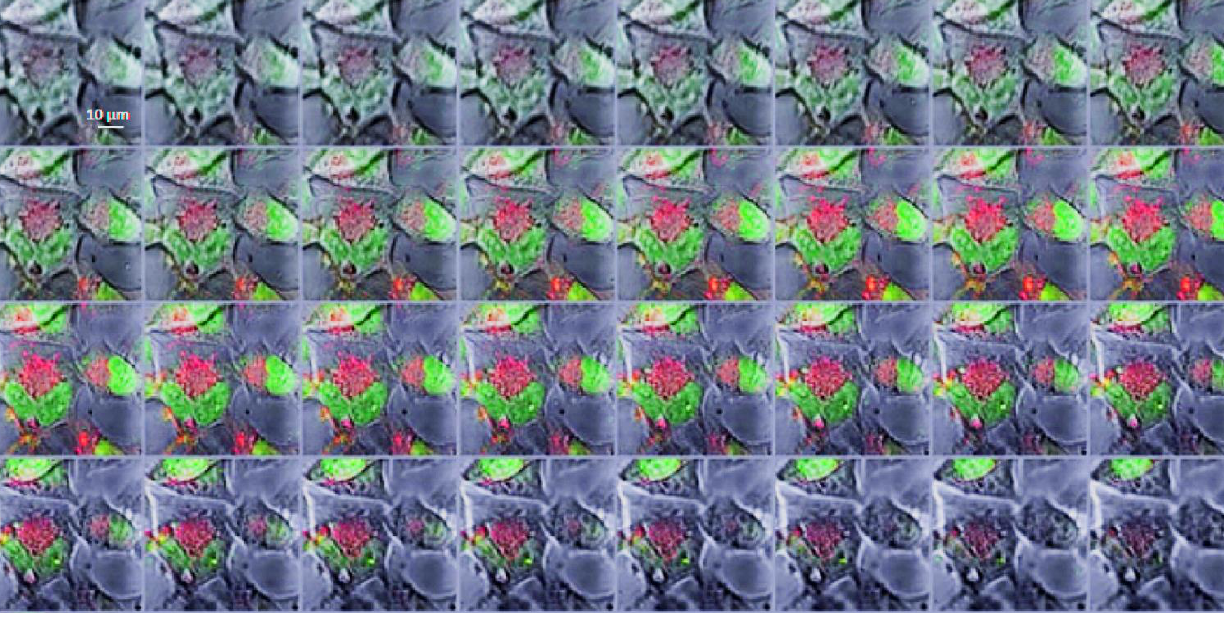
Figure 6. Gallery of merged images acquired along the z-axis of SYBR Green I-stained T98G cells treated with the HSA-Cy5-Hcy-TFAc-B 12 H 11 conjugate. Cell nuclei are visible as a green color. HSA-Cy5-HcyTFAc-B 12 H 11 is visible as a red color. Every subsequent image was taken 0.68 μm higher than the previous one. Scale bars: 10 μm.